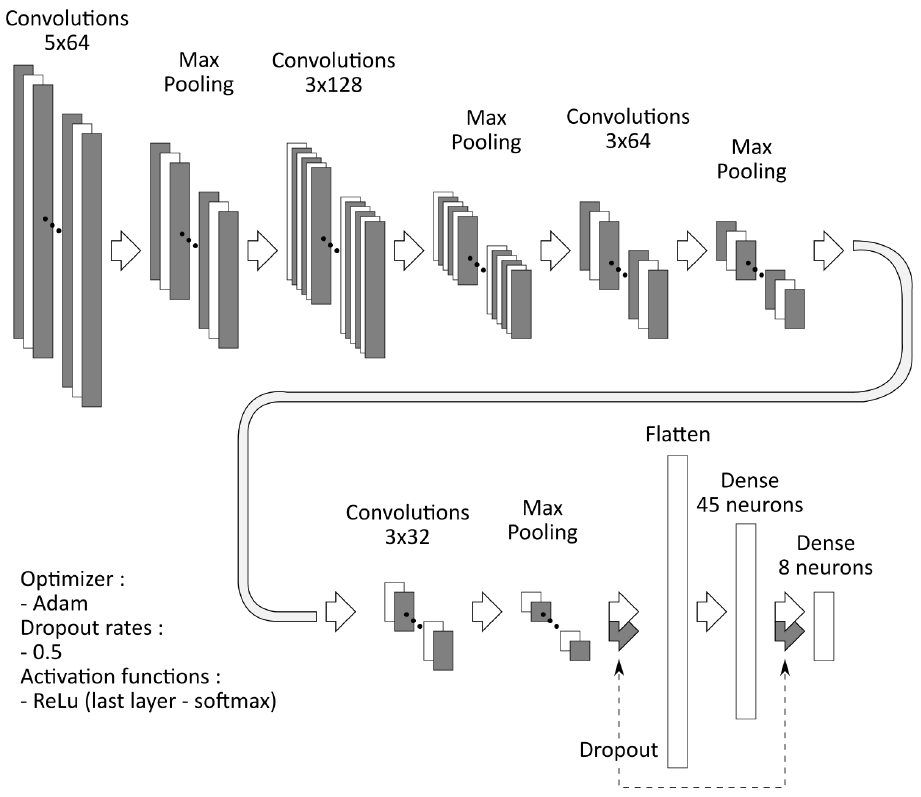
Figure 5. A structure of the convolutional neural network from the classification